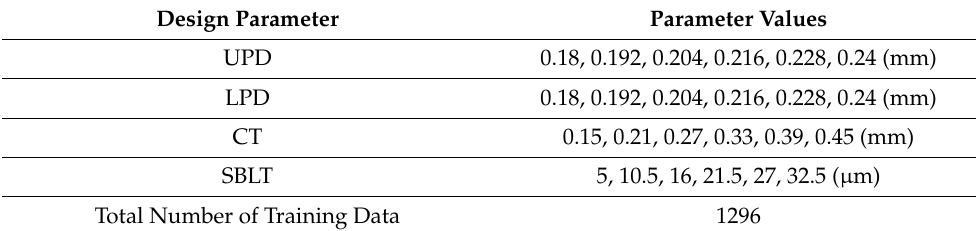
Table 8. Design parameters for 1296 training